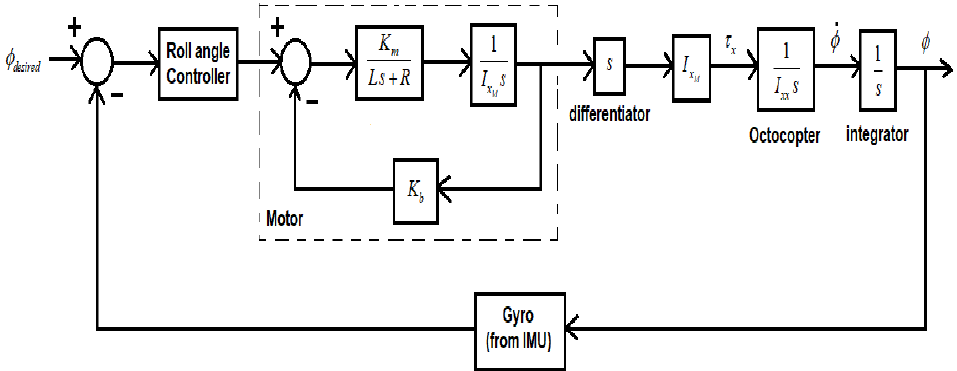
Figure 9. Roll attitude control loop.